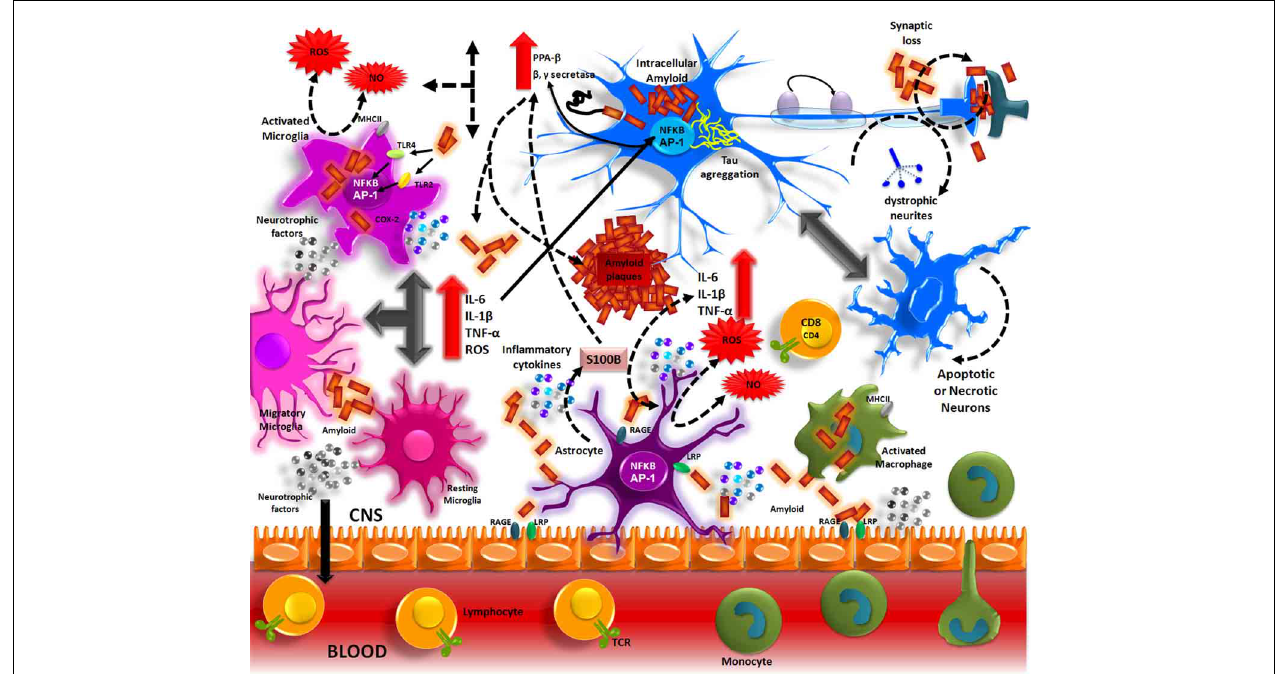
FIGURE 1 | Inflammation in Alzheimer’s disease. The A β peptide produced by APP processing, form aggregates that activate microglia through TLRs and RAGE receptors. These receptors in turn, activate NF- κ B and AP-1 transcription factors, which induce the reactive oxygen species (ROS) production and the expression of inflammatory cytokines (IL-1, IL-6,